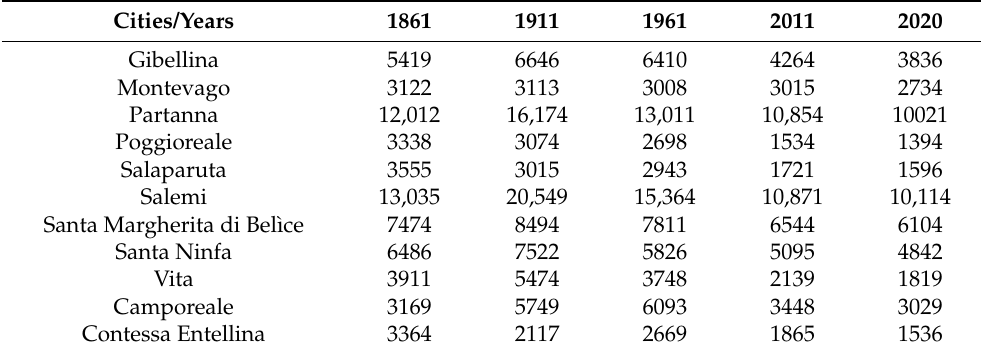
Table 1. Demographic evolution of the municipalities most affected by the earthquake. Source: ISTAT Population